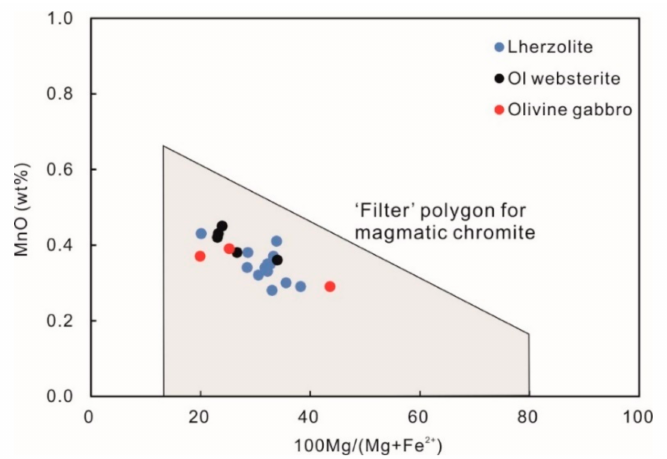
Figure 6. Mg# vs. MnO diagram for type I chromite: the “filter polygon” is from Evans and Evans [55].